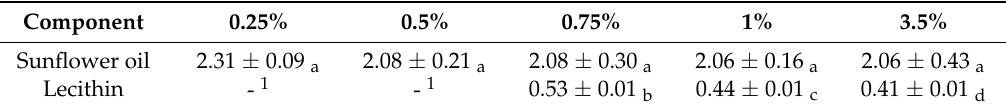
Surface area mean diameter (Sauter mean) of droplets of components at specified concentrations. Each component was incorporated into 1.25% sodium alginate + 2% glycerol solutions ( n = 3 × 2). Component 0.25% Sunflower